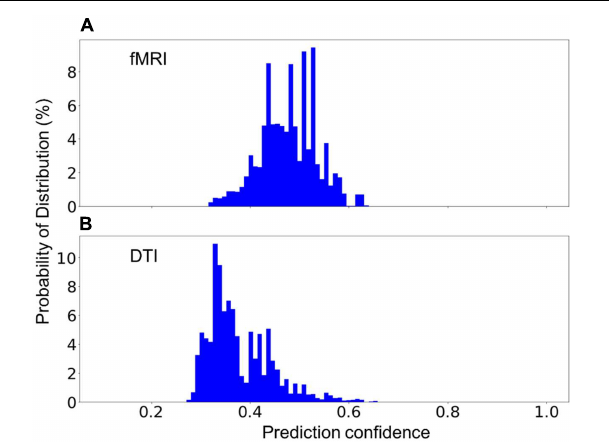
FIGURE 6 | The percent distribution of the classification confidence on predicting two unknown classes, (A) fMRI, and (B) DTI scans. (A) The random forest models are built from 1,200 scans from each of the sequence types, 1–5, and 7, listed in Table 2 , i.e., without the fMRI scans. (B) The random forest models are built from 1,200 scans from each of the sequence types, 1–4, 6, and 7, i.e., without DTI scans. The data are collected from 20 separate